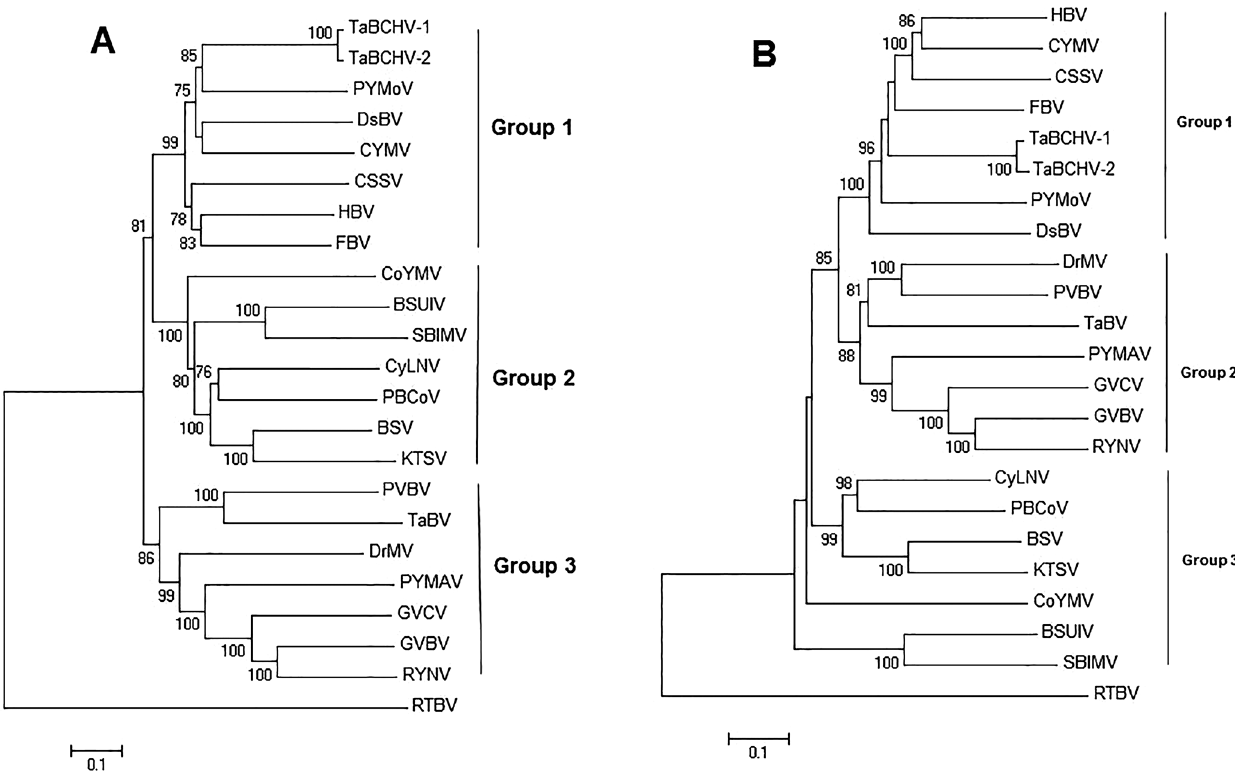
Fig 3. Neighbor-joining phylogenetic trees of badnaviruses generated from the full genomic sequences (A) and putative amino acid sequences of ORF3 (B). The phylogenetic trees were rooted by using the genome sequence of Rice tungro bacilliform virus (RTBV) (A) and the polypeptide of RTBV (B). Branch lengths are proportional to genetic distances. Numbers at the nodes of the branches represent bootstrap values (1000 replicates).